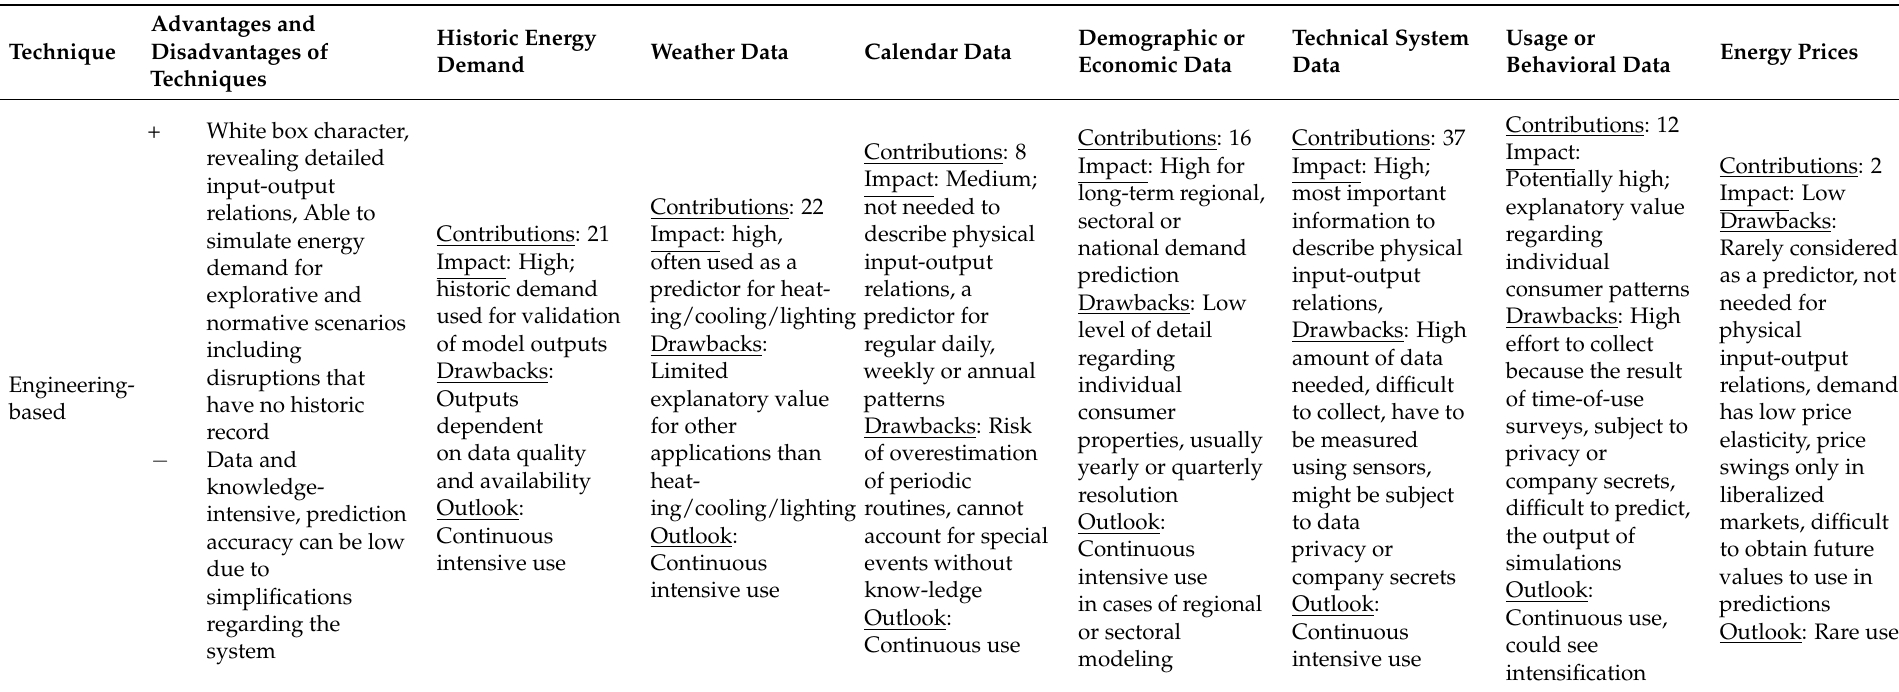
Table 8. Techniques and input data used (5/5). Continuation of Table